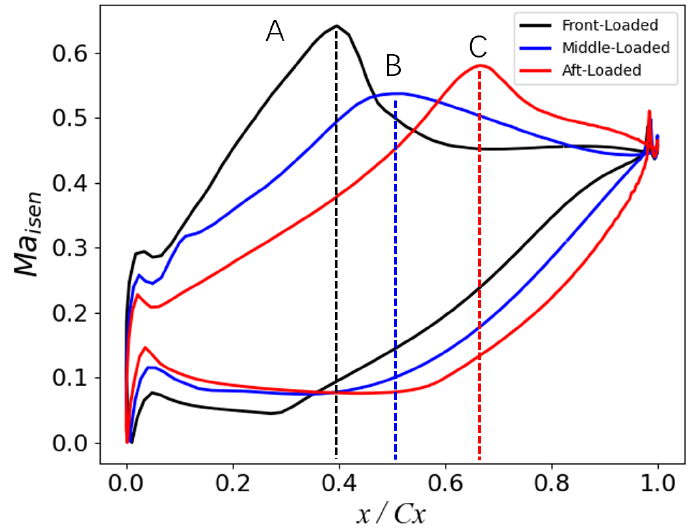
Figure 16. Different loading distribution on three vanes.